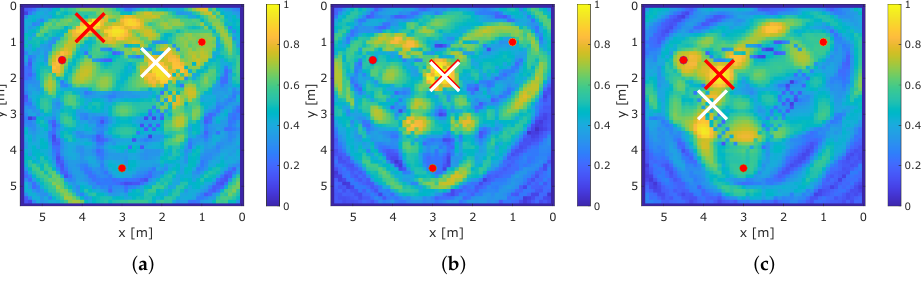
Figure 12. Exemplary results for multi-static radar. ( a ) MSR at position 6. ( b ) MSR at position 7. ( c ) MSR at position